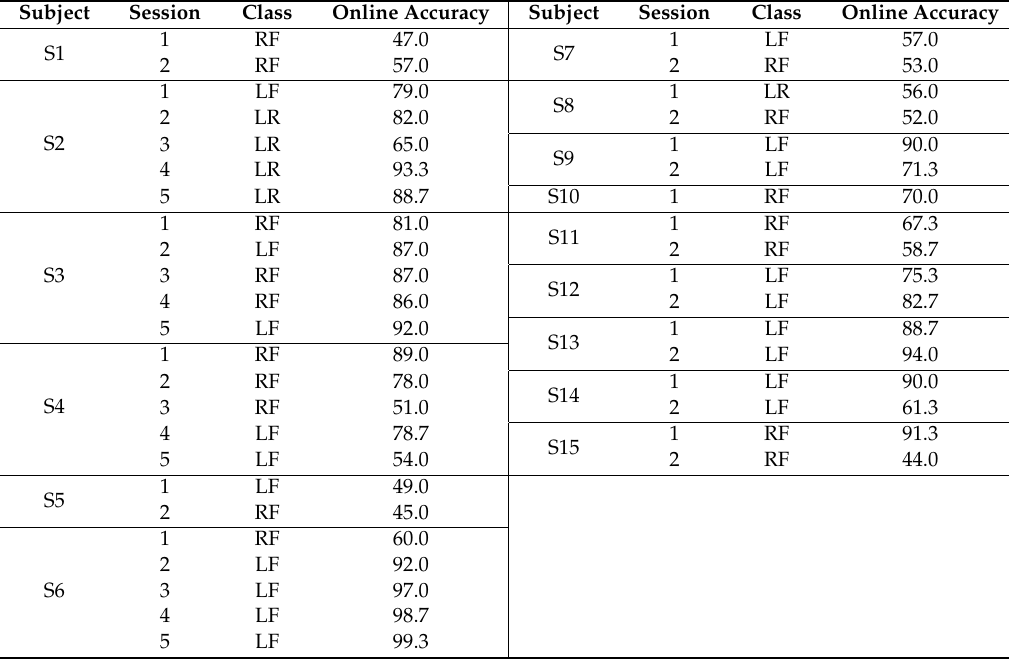
Table 1. Details of online BCI data and BCI classification